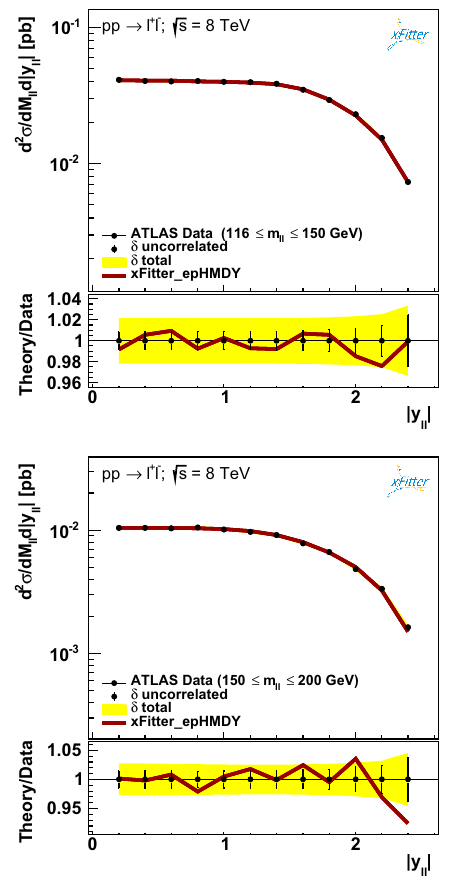
Fig. 3 Comparison between the results of the fit and the ATLAS data for the ( m ll , | y ll | ) double-differential Drell–Yan cross sections as func- tions of | y ll | , for the first two m ll bins. The comparisons are shown both in an absolute scale ( upper plots ) and as ratios to the central value of the experimental data in each y ll bin ( lower plots ). The error bars on the data points correspond to the bin-to-bin uncorrelated uncertainties, while the yellow bands indicate the size of the correlated uncertain- ties. The solid lines indicate the theory calculations obtained using the results of the fit